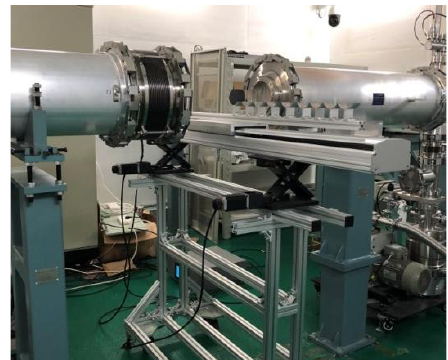
Fig. 6. Schematic for the NTOX spectrometer (upper) and sample changer